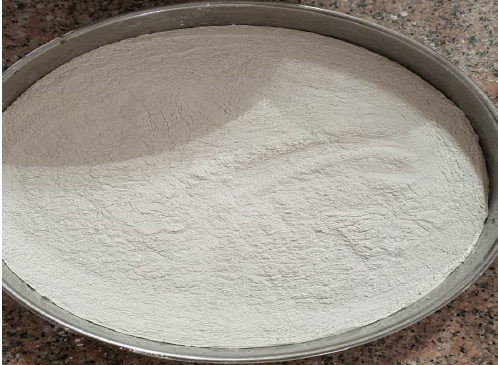
Figure 1. Sample of the used bentonite.